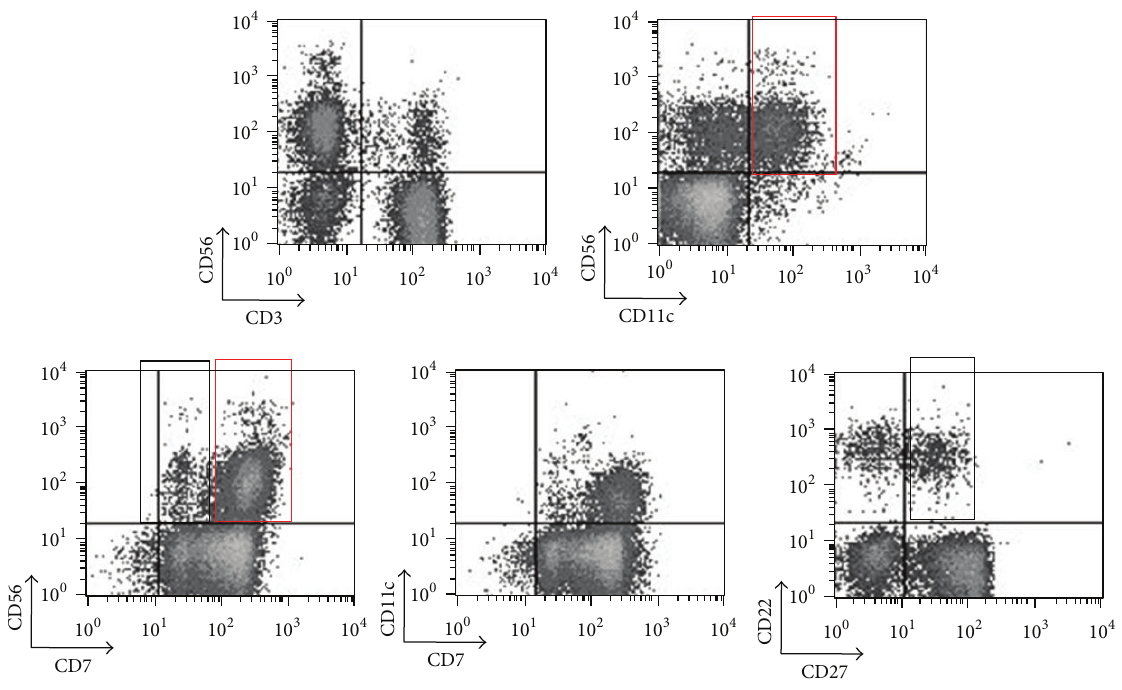
Figure 2: Surface staining of CD3, CD56, CD7, CD11c, CD20, CD22, and CD27 epitopes with methanol-based permeabilization. Freshly isolated human PBMCs from a healthy donor were fixed using 2% paraformaldehyde, permeabilized in methanol, and stained with MoAb clones against CD3, CD56, CD7, CD11c, CD22, and CD27. Lymphocytes were gated on forward/side light scatter properties. Successful discrimination of CD56+CD3 − , CD56+CD3+, CD56 − CD3+, CD56+CD11c+, CD56+CD11c − , CD56+CD7+, CD22+CD27+, and CD22+CD27 − cells was demonstrated. A clear distinction between high CD56 and medium/low CD56 as well as high CD7 and medium/low CD7 was noted (first row, right plot and second row, left plot,